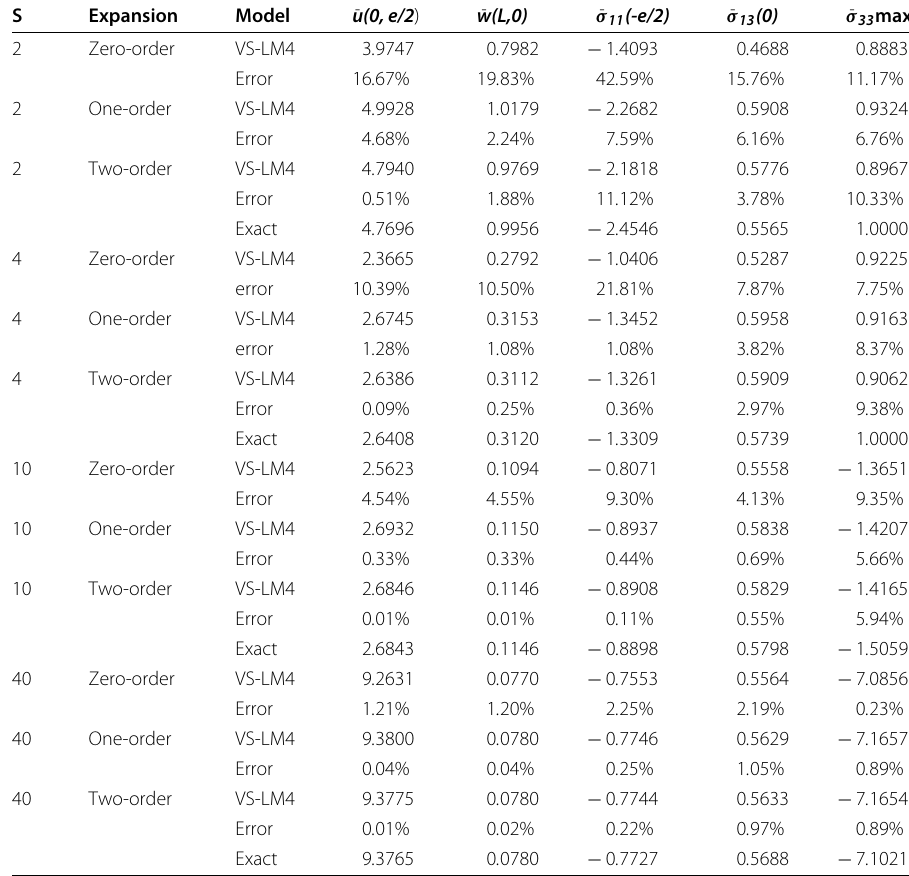
Table 2 Influence of the order-approximation of 1 /μ with respect to S —one layer [0 ◦ ] — φ = = π/ 3 —mesh 26 × 10— N z